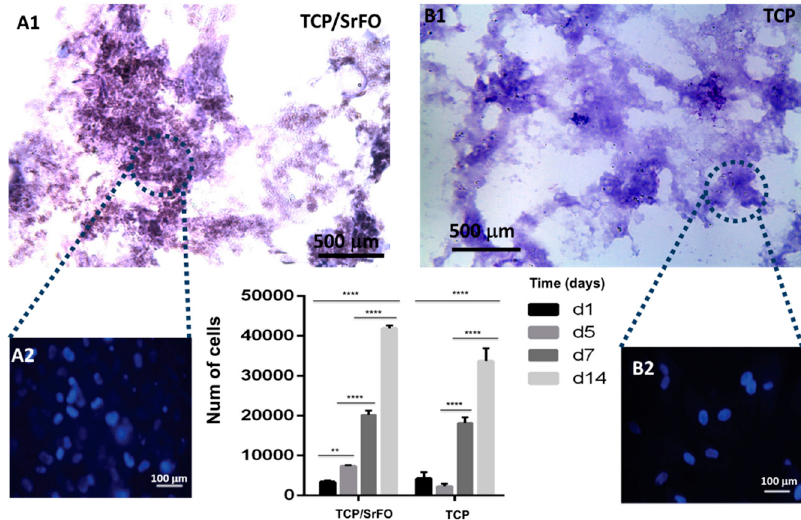
Figure 9. H & E staining on sliced TCP/SrFO (A1) and TCP (B1) scaffolds and nuclei staining (A2 and B2 respectively) of HDPSCs used for the viability quantification. Figure adapted from Mart í n-del-Campo et al. [16] with permission from The Royal Society of Chemistry. Stars show significant di ff erences throughout days * ( p < 0.0049) *** ( p < 0.0001) **** ( p <